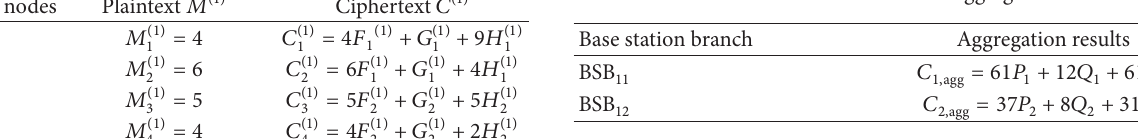
Table 6: The intercluster data